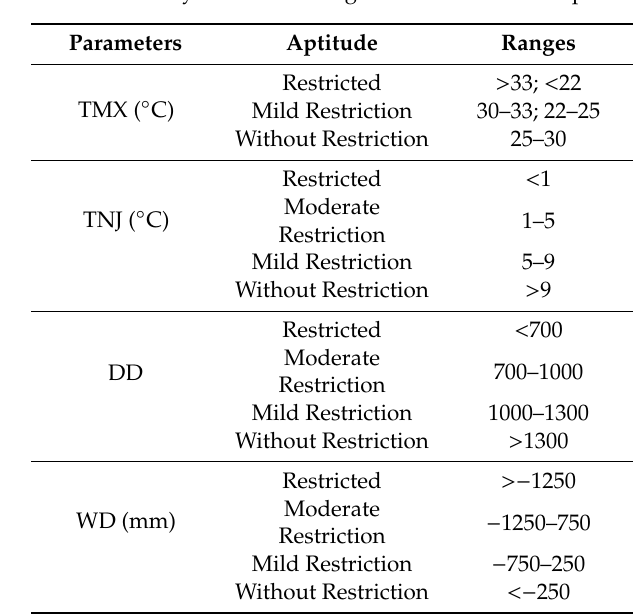
Table 3. Thermal and hydric critical ranges for castor bean adoption in